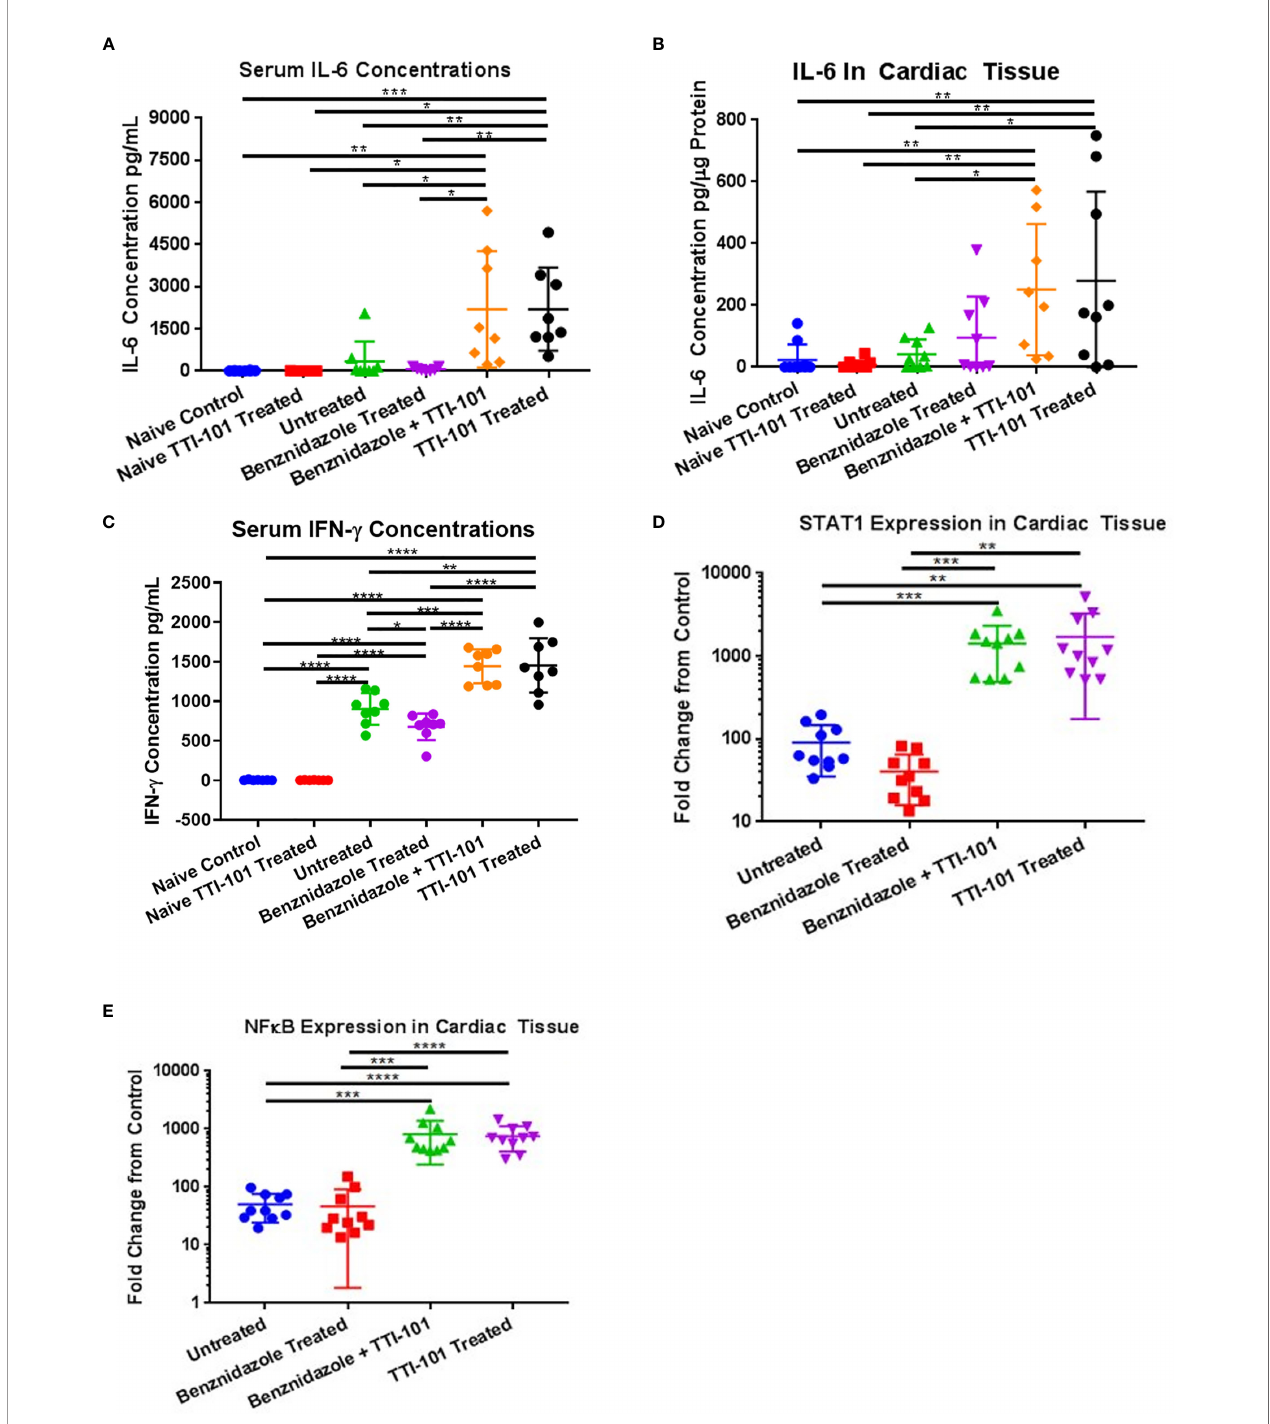
FIGURE 7 | In fl ammatory signaling induced by signal transducer and activator of transcription-3 (STAT3) inhibition. Pro-in fl ammatory signaling mechanisms in fl uenced by STAT3 activity were measured in the serum and cardiac tissues of all animals after treatment with TTI-101. Shown are individual levels of serum interleukin-6 (IL-6) (A) , cardiac IL-6 (B) , and serum interferon- g (IFN- g ) (C) . Downstream effectors of IL-6 and IFN- g were measured in cardiac tissue. Cardiac gene expression levels of STAT1 (D) and NF- k B (E) are shown as fold increase above naive controls. Representative images from one of two replicate experiments are shown. Error bars represent SD. Data were analyzed with Student ’ s t-test; *p < 0.05, **p < 0.01, ***p < 0.001, ****p <